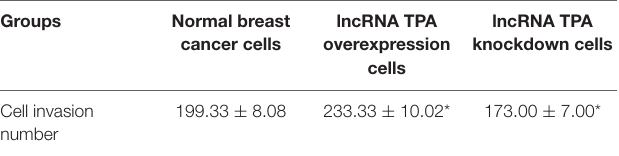
TABLE 5 | The effect of lncRNA TPA overexpression and knockdown on cell invasion ( upchi ± S, n = 3). Groups Normal breast lncRNA TPA cancer cells overexpression cells